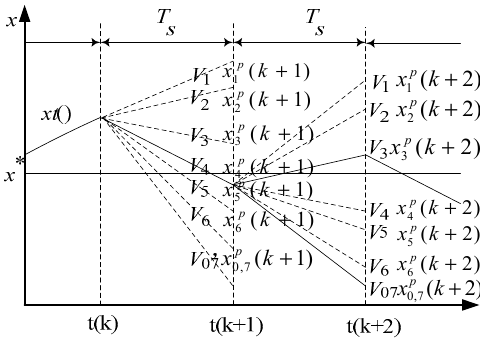
Table 2. Switching state and voltage vector.